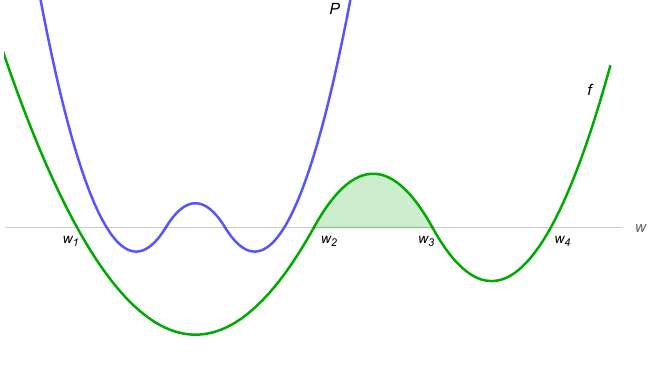
Figure 1 . A schematic plot showing the root structure of f and P . Here the shaded green region indicates the domain of w where the metric is